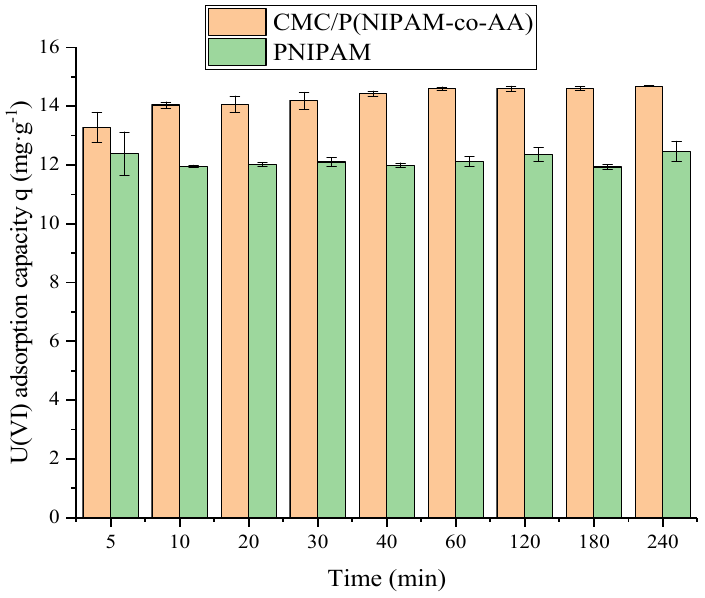
Figure 5. Effect of reaction time on U(VI) adsorption by CMC/P (NIPAM-co-AA) and PNIPAM. Figure 5. E ff ect of reaction time on U(VI) adsorption by CMC / P (NIPAM-co-AA) and PNIPAM. The kinetics of the adsorption of U(VI) by PNIPAM and CMC / P (NIPAM-co-AA) were